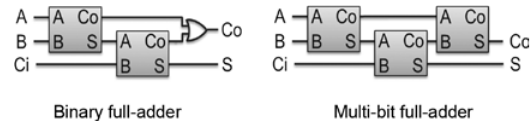
Figure 16: Full adders via half-adder composition.